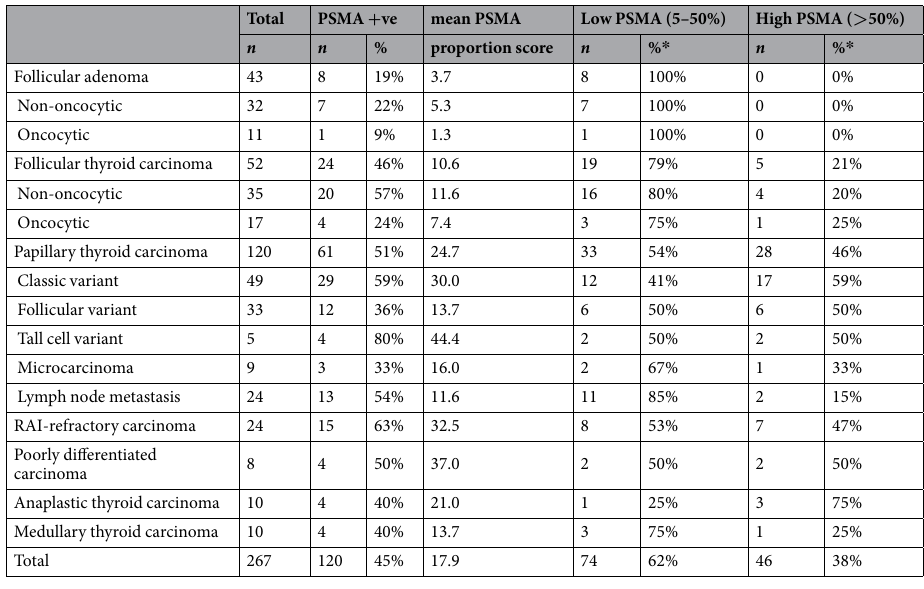
Table 1. PSMA expression in the microvessels of thyroid tumors. * Per cent out of all PSMA-positive cases within particular tumor